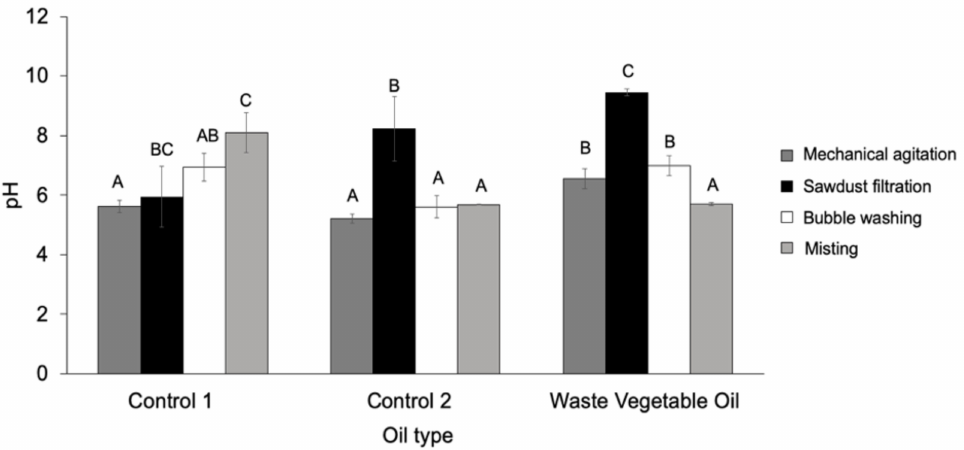
Figure 3. pH from biodiesel